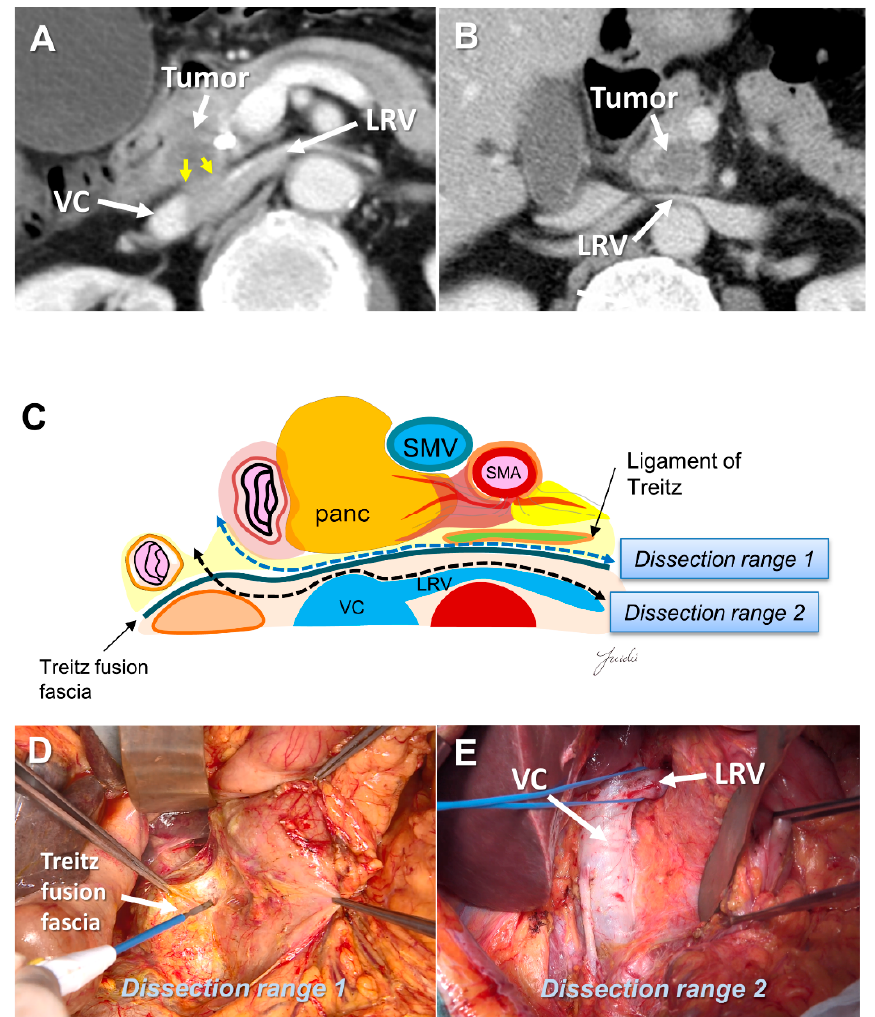
Figure 3. ( A ) Tumor extension to the posterior side of the pancreatic head is observed on the pre- operative MDCT findings. ( B ) Tumor extension to the posterior side of the pancreatic head is